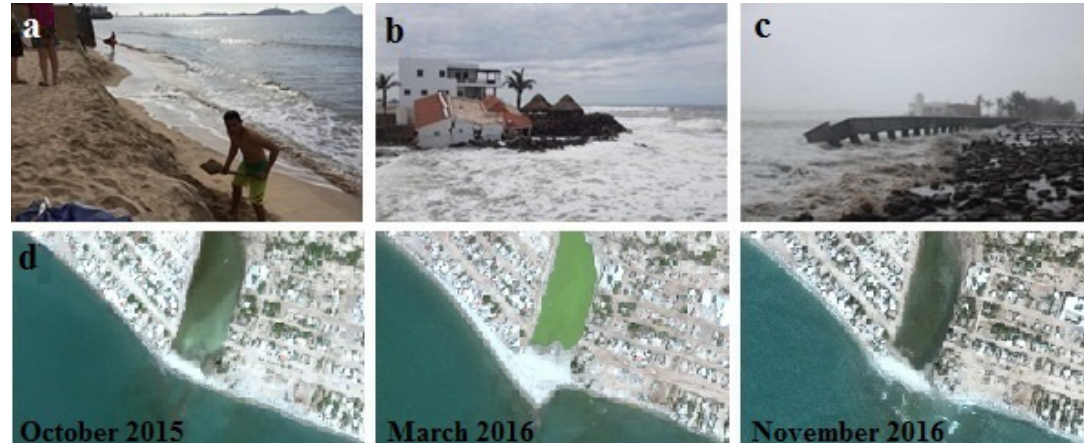
Figure 8. Example of the impacts of tropical cyclones and cold fronts on the GC coast: ( a ) Mazatlán beach in Sinaloa, affected by cyclone Willa in 2018; ( b ) Altata beach in Sinaloa, affected by cyclone Bud in 2018; ( c ) Las Glorias beach in Sinaloa, affected by cyclone Odile in 2014; ( d ) Las Bocas beach in Sonora, affected by cold front passages between October 2015 and March 2016. Source: Google Earth and newspapers Noroeste, El Universal and La Pared.